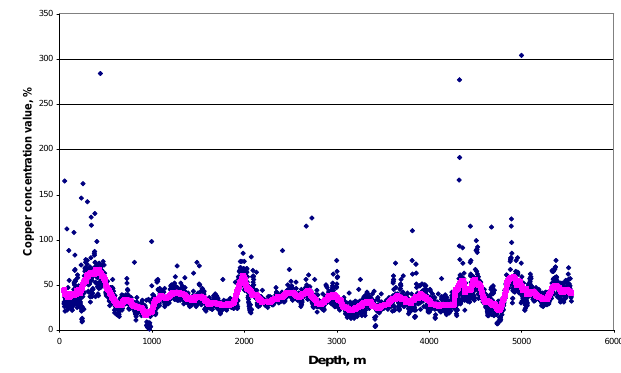
Fig. 13. Relation between estimated autocorrelation coefficients (blue diamonds) and second derivative of corresponding continu- ous function (Eq. 9). Best-fitting straight line (colored red) will be used for extrapolation to the origin (see Fig. 14).